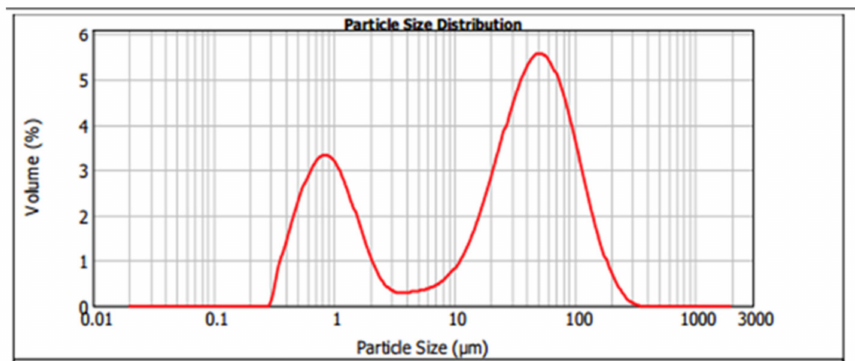
Figure 26. Crude oil droplets size distribution in water. Heavy crude oil from the Orinoco Belt (Venezuela). Measuring equipment: Malvern Mastersizer, Model